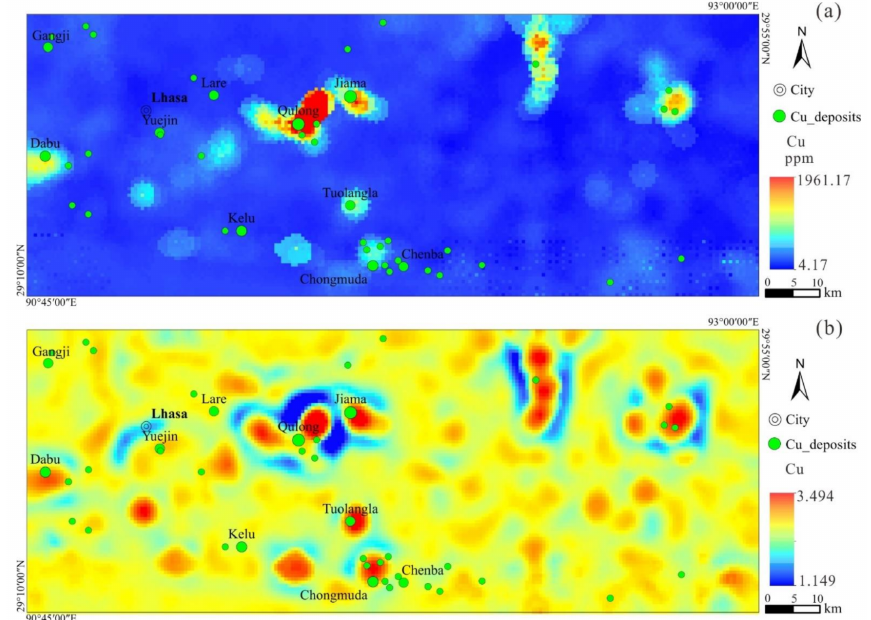
Figure 10. ( a ) The distribution of Cu by ordinary kriging and ( b ) the kriging interpolation-based